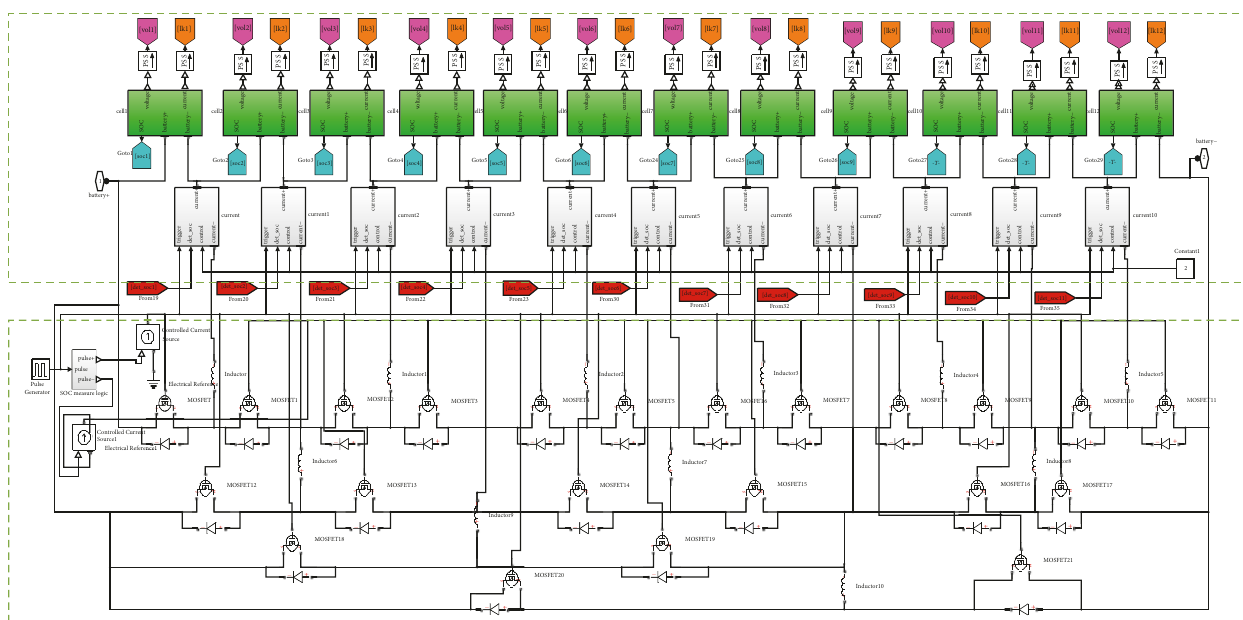
Figure 7: Example of battery model including SOC estimator (top) and cell balancing